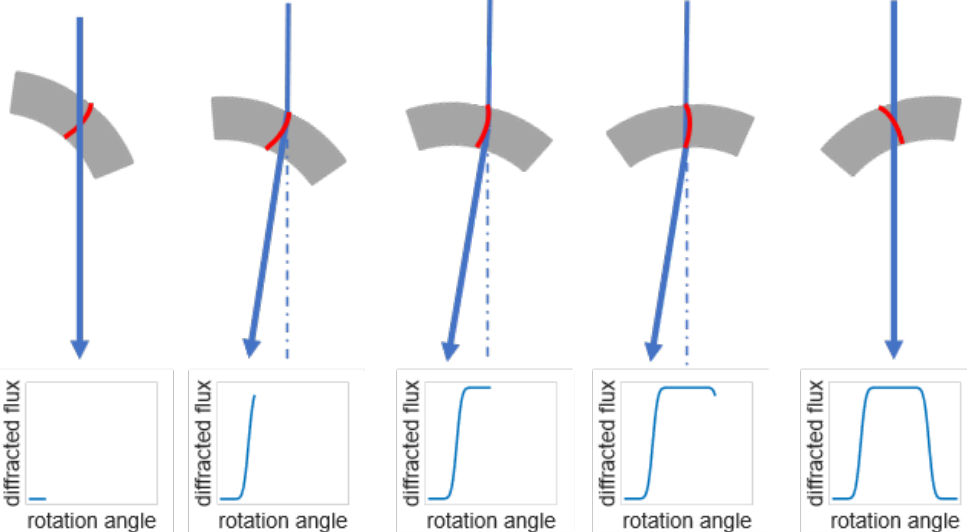
Figure 15. Example for Quasi Mosaic curvature (in red). Crystal rotates into and out the diffraction condition, the width of the rocking curve indicates the convolution of Darwin width and lattice planes bending